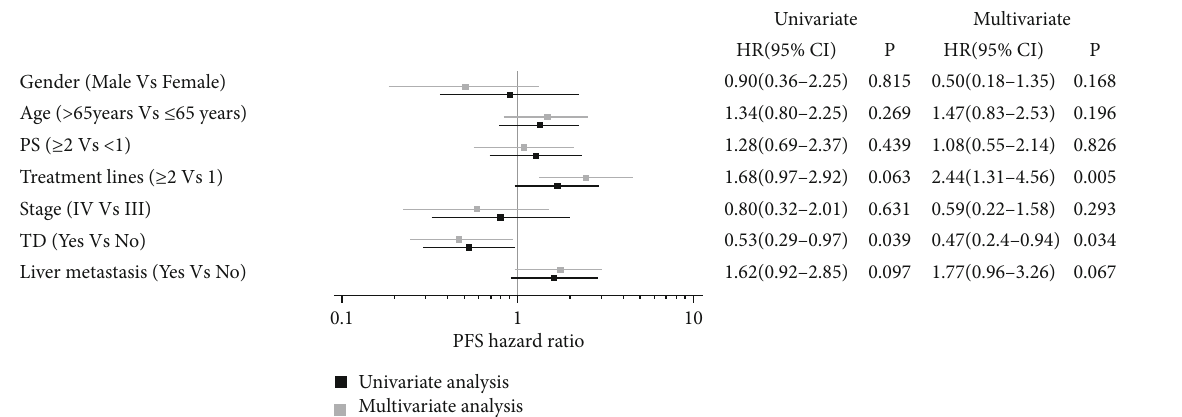
Figure 3: Prognostic factors for PFS by univariate and multivariate analysis in ESCC patients received camrelizumab.